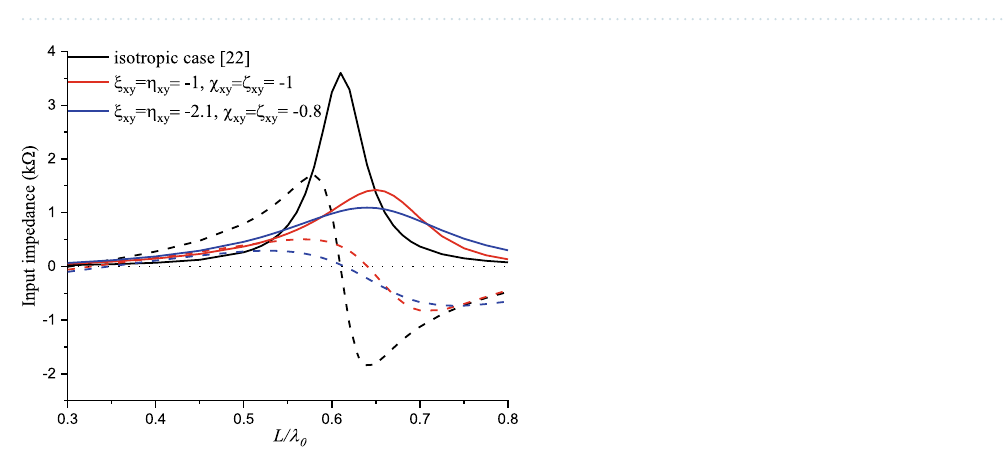
0.5 ) case, ( a – c ) electric ς xy = = −